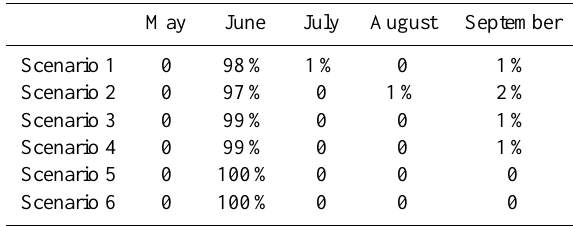
Table 3. The optimal harvest ratios from May to September for each scenario.